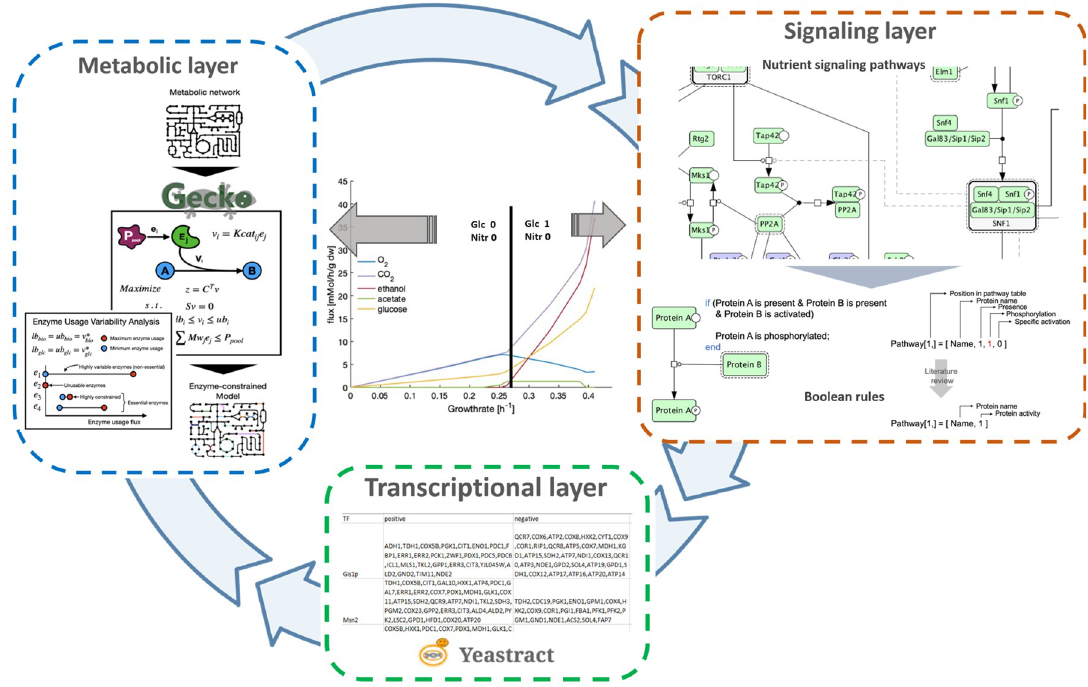
Fig 1. Schematic representation of the hybrid model. The hybrid model consists of a vector-based Boolean module of nutrient signaling and an enzyme constrained module of the central carbon metabolism. The Boolean module is a dynamic module including Snf1, PKA, and TORC1 pathway as well as crosstalk between them. The dynamic module reaches a steady-state and the activity of the transcription factors acts as input in a regulatory network constraining the enzyme constraint model of the central carbon metabolism. The solution is used to determine the activity of the Boolean